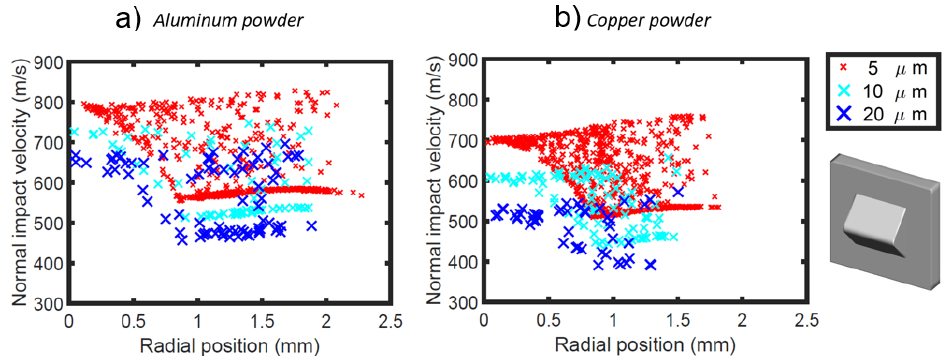
Figure 12. Normal impact velocities and radial location of ( a ) aluminum and ( b ) copper particles for the case with the smooth wall.